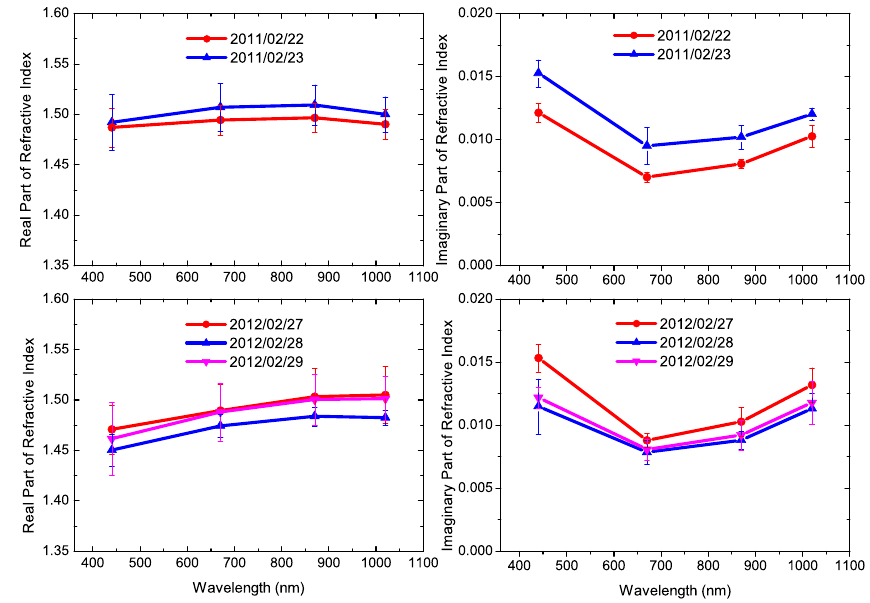
Fig. 8. Daily average aerosol refractive index observed in haze days (top: 2011 event, bottom: 2012 event).